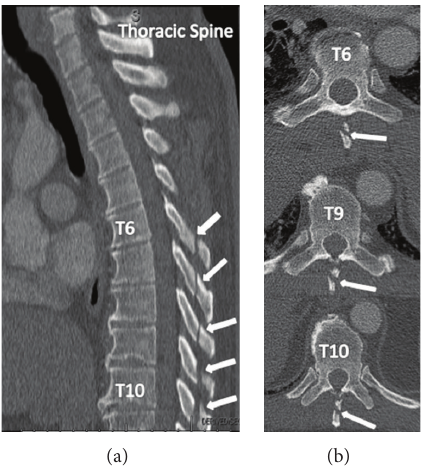
Figure 3: (a) Sagittal CT demonstrating thoracic spinous process fractures (arrows) spanning from T6 to T10. (b) Axial CT showing select (T6, T9, and T10) spinous process fractures (arrows). No evidence of vertebral body or intralaminar extension is